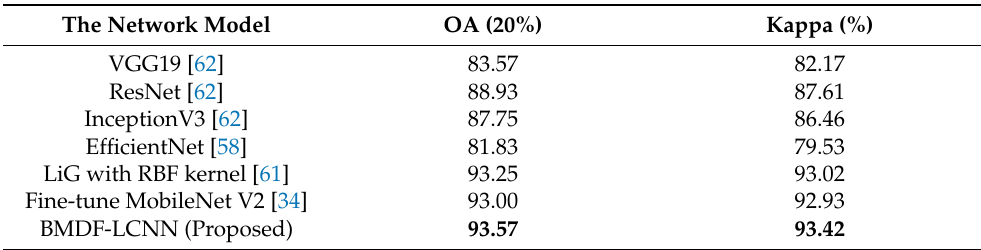
Table 9. Comparison of Kappa values between the proposed method and some advanced methods on 20% NWPU45